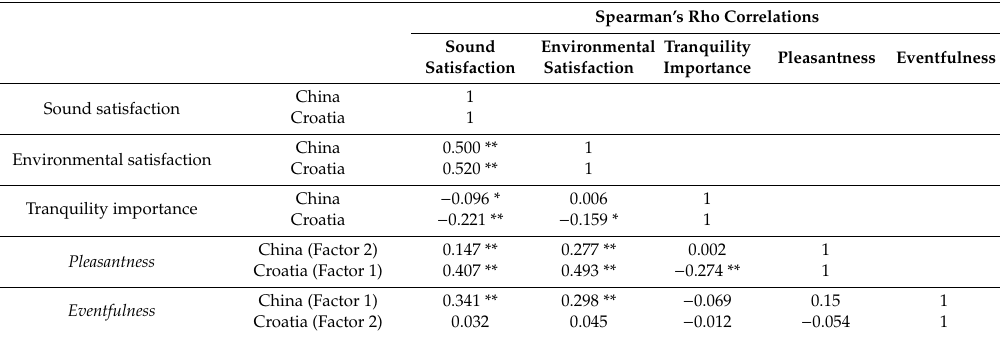
Table 3. Average score and Spearman’s rho correlations between subjective satisfaction, tranquility importance and soundscape factors.